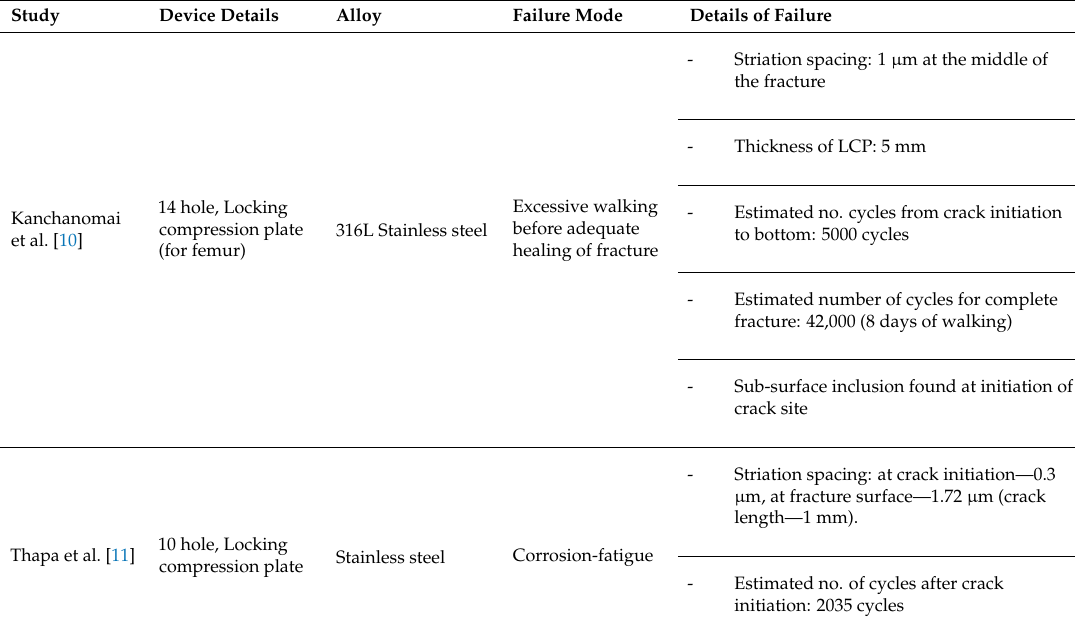
Table A1. Summary of orthopaedic device failure